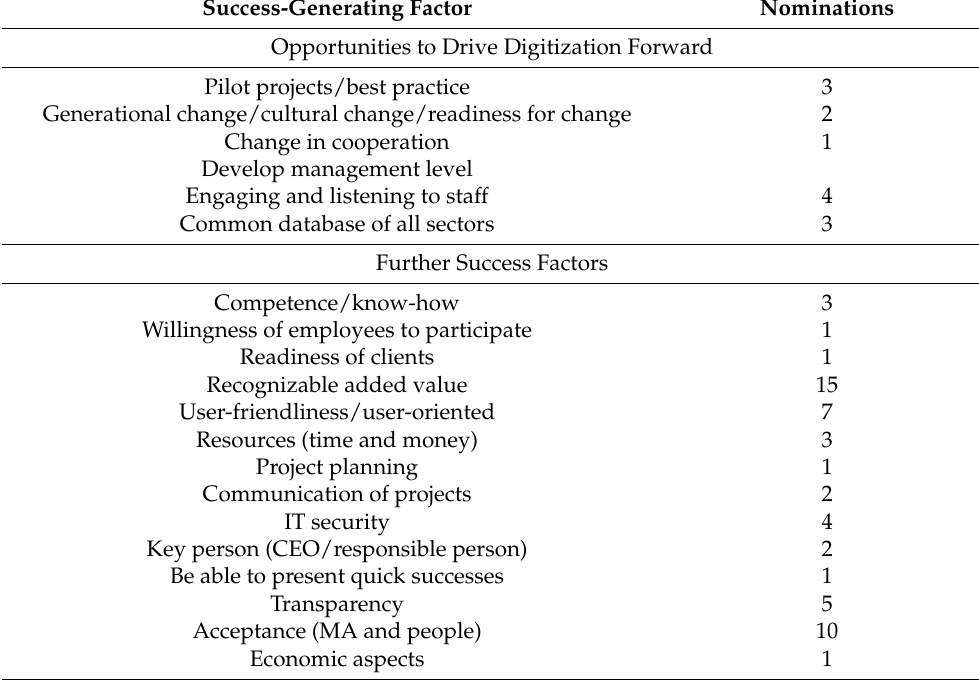
Table 5. Freely named success factors ( n =